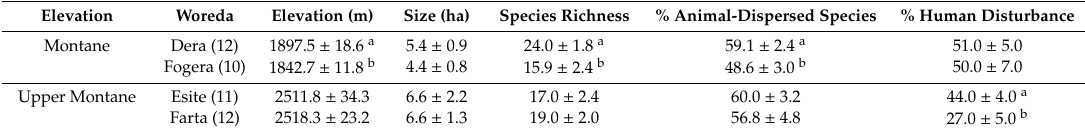
Table 1. Characteristics of each Woreda within each elevational zone. Within each elevational zone, factors were compared across Woredas using t -tests. Values in brackets after the Woreda are the number of church forests within each Woreda. Values with di ff erent letters between Woredas within each elevational zone denote significant di ff erences at p <